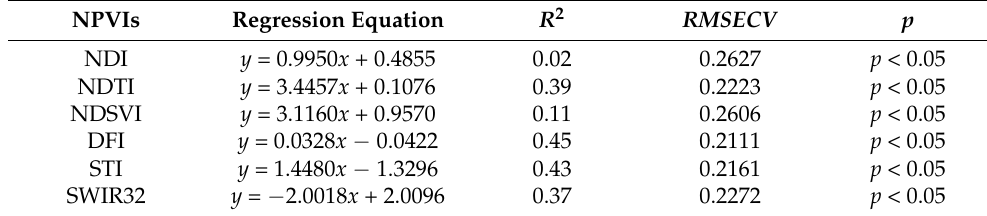
Table 4. Parameters of linear regression analyses between NPVIs and f NPV